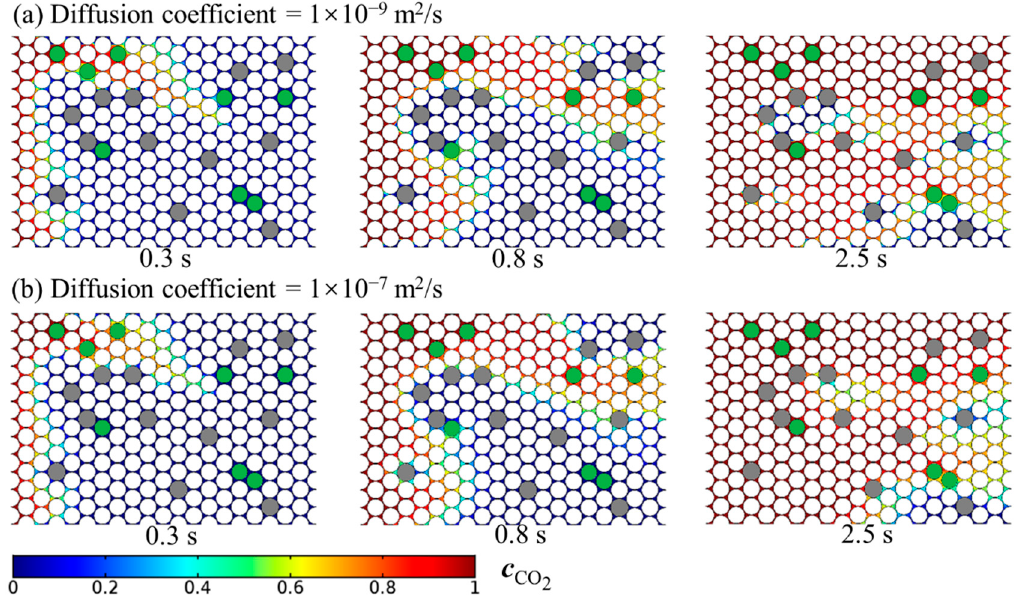
Figure 8. Temporal and spatial evolution of the dissolved CO 2 plume when the CO 2 diffusion coefficient is, respectively, equal to ( a ) 1 × 10 − 9 m/s and ( b ) 1 × 10 − 7 m/s.